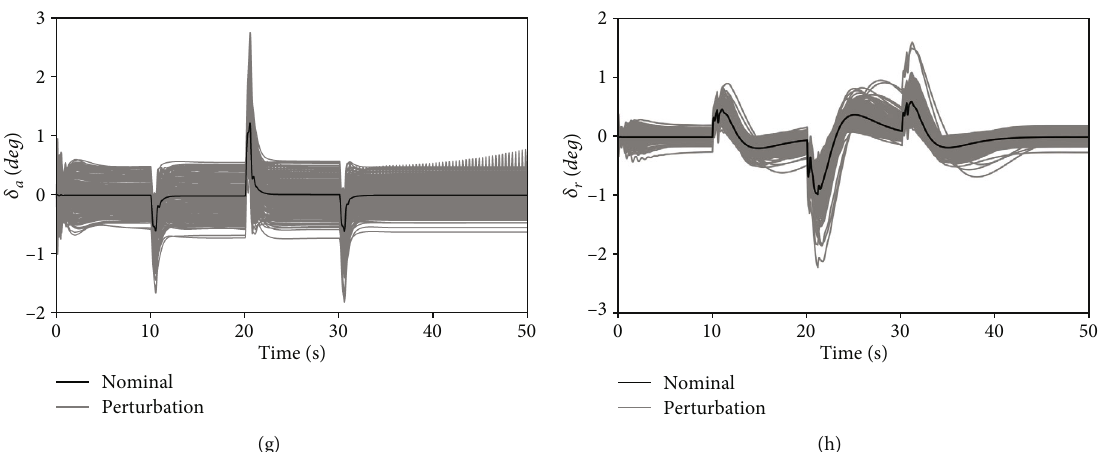
Figure 15: Results of MC simulations of the ESO-based control. (a) Bank angle response. (b) Lateral acceleration response. (c) Roll angular rate response. (d) Yaw angular rate response. (e) Sideslip angle response. (f) Velocity response. (g) Aileron command value. (h) Rudder command value.